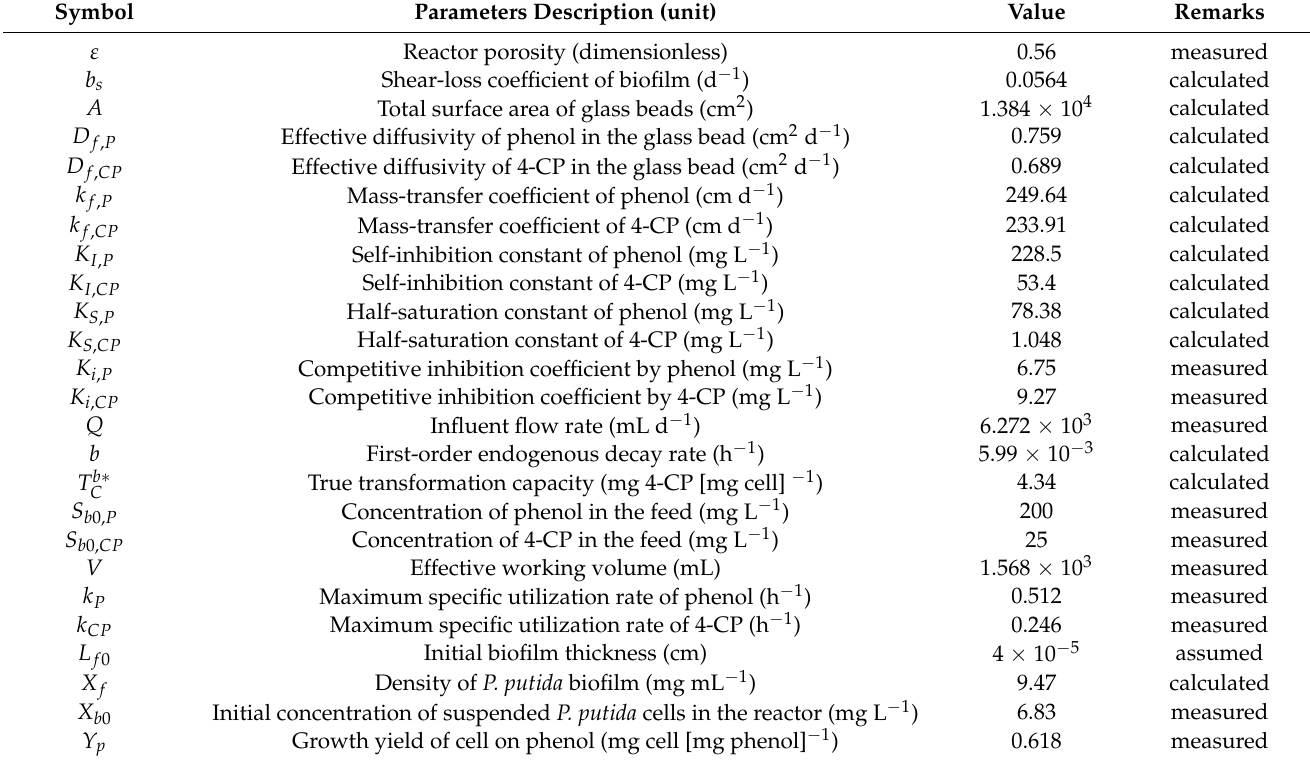
Table 1. Summary of the kinetic constants as well as the operation conditions for the model prediction. Symbol Parameters Description